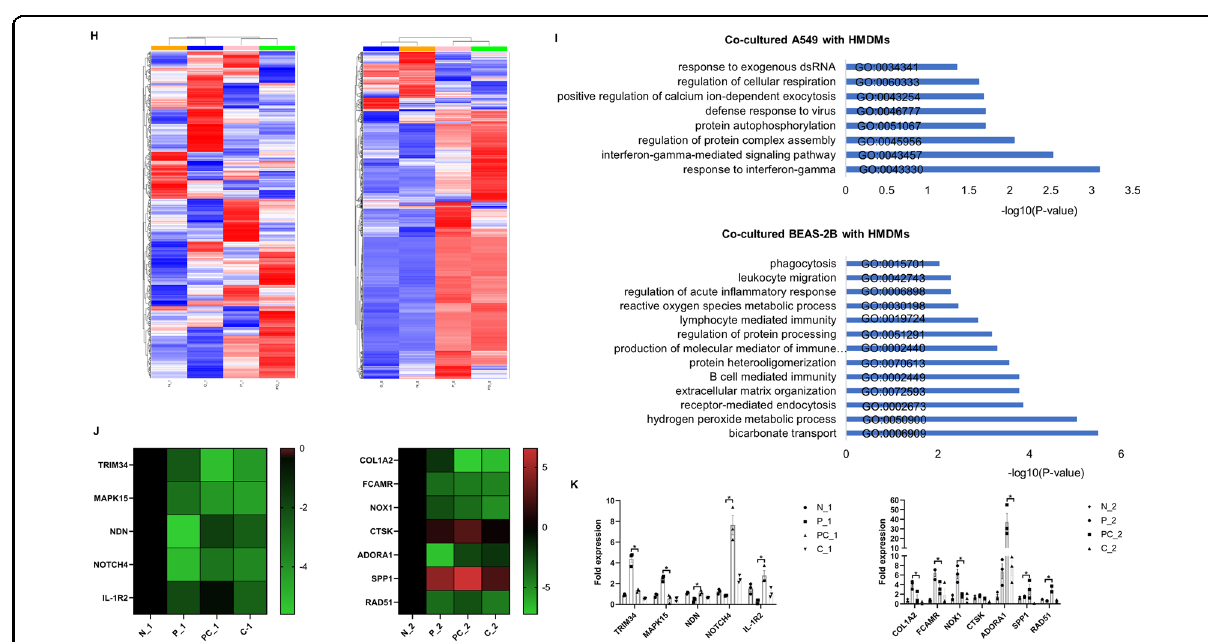
Fig. 2 Targeted intracellular signaling pathways and RNA-seq transcriptional pro fi ling identi fi cation of IL-38 target genes in the co- cultures. A549 cells (1 × 10 5 ) or BEAS-2B cells (1 × 10 5 ) with HMDMs (3 × 10 5 ) were co-cultured with or without rhIL-38 pretreatment for 30